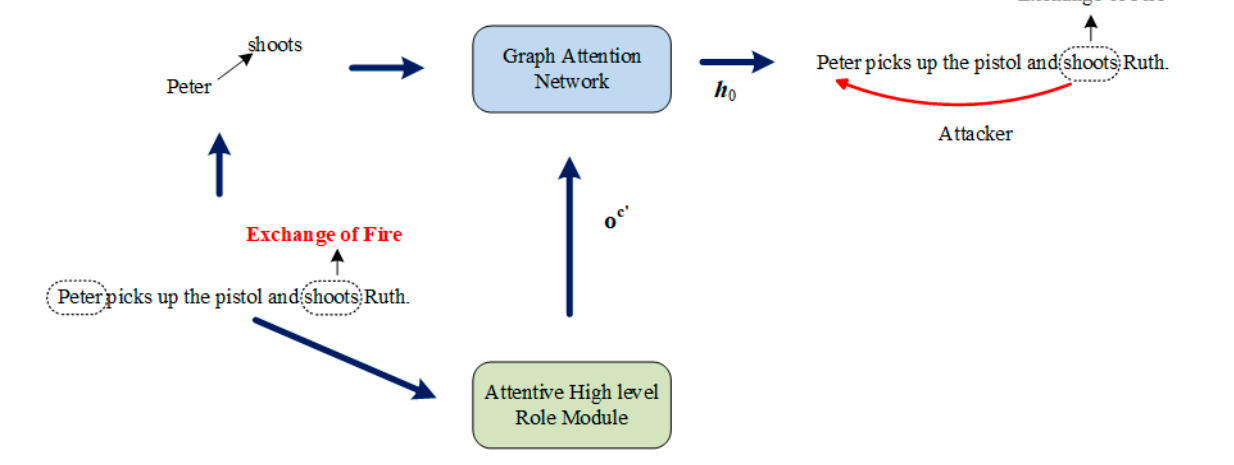
Figure 5. The details of the event argument extraction.